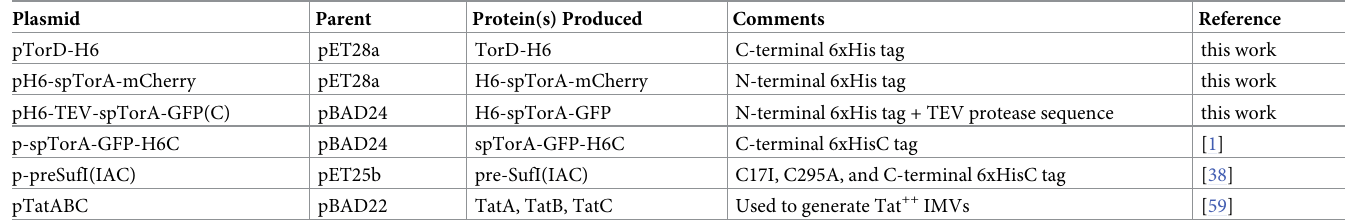
Table 1. Plasmids encoding overproduced proteins. Plasmid